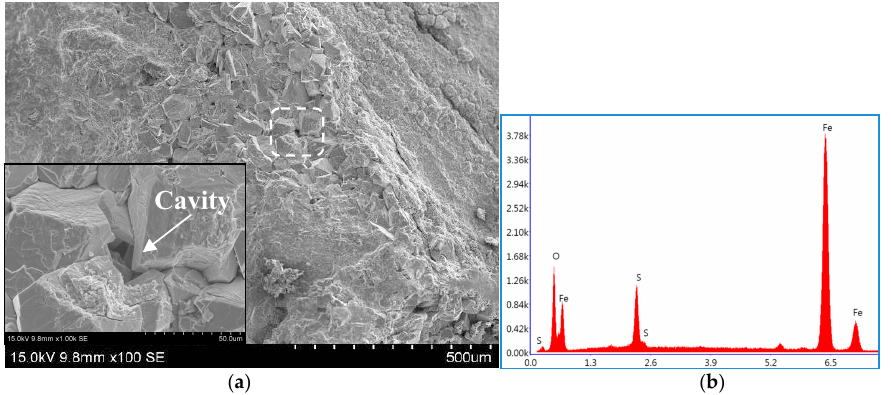
Figure 4. Typical SEM observation of corrosion fi lm covering SSC fracture surface in ( a ) DCB sample and ( b ) its EDS (energy dispersive spectroscopy) spectrum.